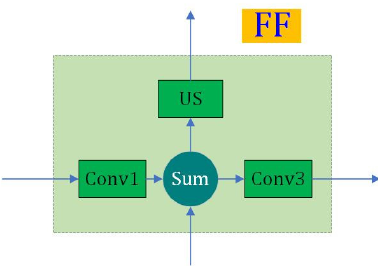
Figure 4. The structure of FF.